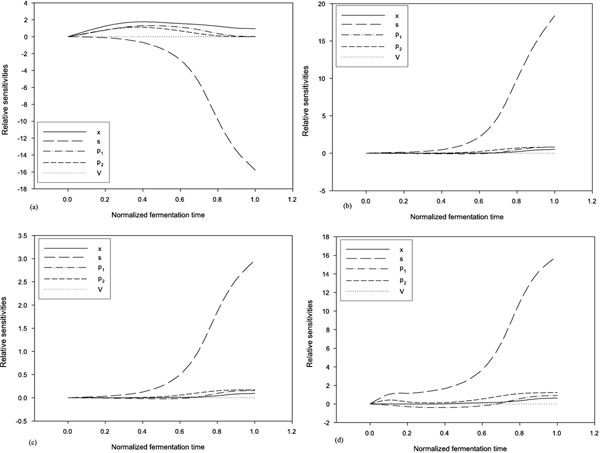
Dynamic relative sensitivities with respect to μ
m
, 



Y


p
1

/
s




, 



Y


p
2

/
s




, and s
F
. (a) relative sensitivities with respect to μ
m
; (b) relative sensitivities with respect to 



Y


p
1

/
s




; (c) relative sensitivities with respect to 



Y


p
2

/
s




; (d) relative sensitivities with respect to s
F
. The horiziontal scale is in normalized fermentation time (t/t
f
).